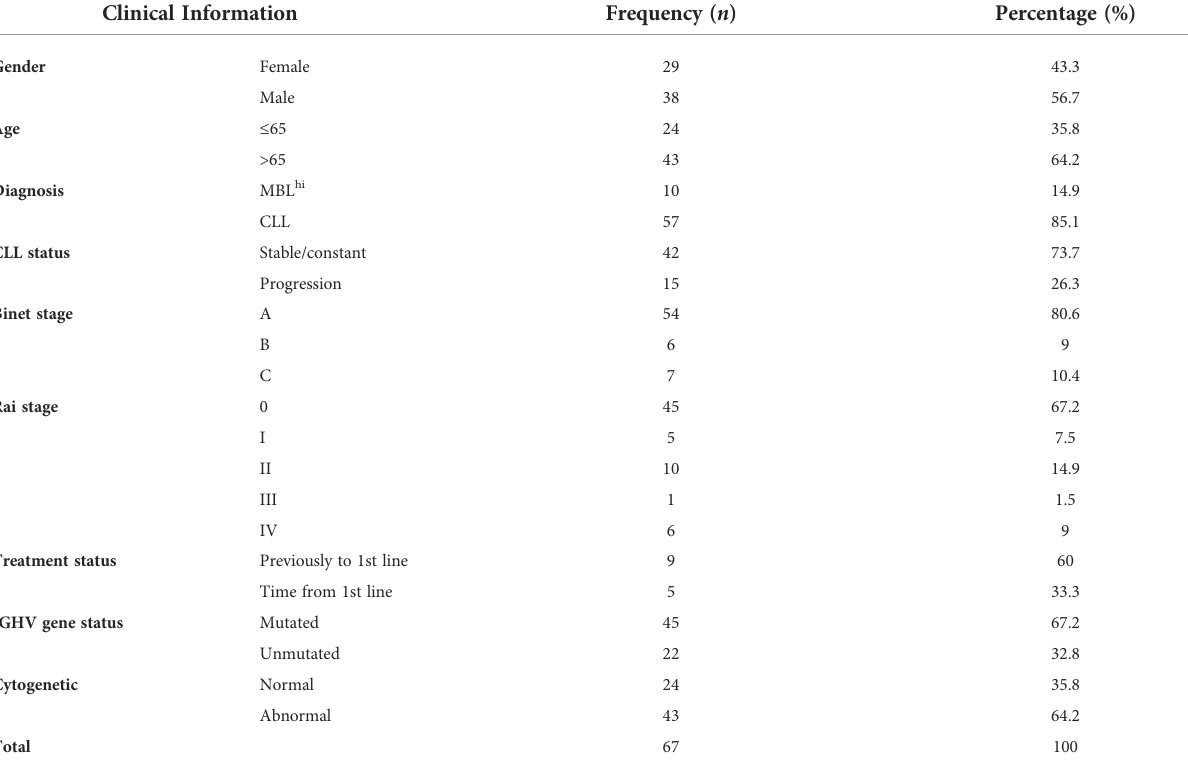
TABLE 1 Clinical and biological characteristics of patient cohort. Clinical